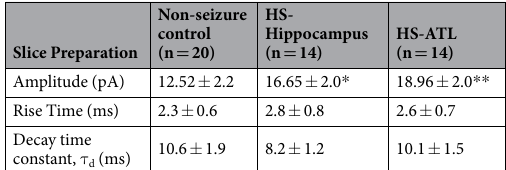
Figure 2. Spontaneous EPSCs in pyramidal neurons of resected brain samples. ( A ) Sample recordings of spontaneous EPSCs recorded from pyramidal neurons of resected brain samples obtained from non- epileptic control (top trace). The second trace shows spontaneous EPSCs recorded from pyramidal neurons of the hippocampal samples of patients with HS at an expanded time scale. Third trace shows recording from pyramidal neurons of the ATL samples of patients with HS. Fourth trace shows recording following superfusion of the HS hippocampal slice with glutamate receptor antagonists APV (50 μ M) and CNQX (10 μ M) for 10 min. Bottom trace shows recording following superfusion of the HS hippocampal slice with GABA receptor antagonist bicuculline (10 μ M) for 10 min. ( B ) Cumulative probability plots of inter-event intervals of spontaneous EPSCs recorded from slice preparations of non-epileptic control and the hippocampal and ATL samples of HS patients. Plots represent data from twenty neurons from twenty patients for non-seizure control, eighteen neurons from the hippocampal samples of fourteen HS patients and sixteen neurons from the ATL samples of fourteen HS patients. Compared to non-seizure controls a significant leftward displacement of the cumulative distribution of inter-event intervals was observed in the hippocampal samples (p = 0.007 according to K-S test) and the ATL samples (p < 0.002 according to K-S test) of patients with HS.